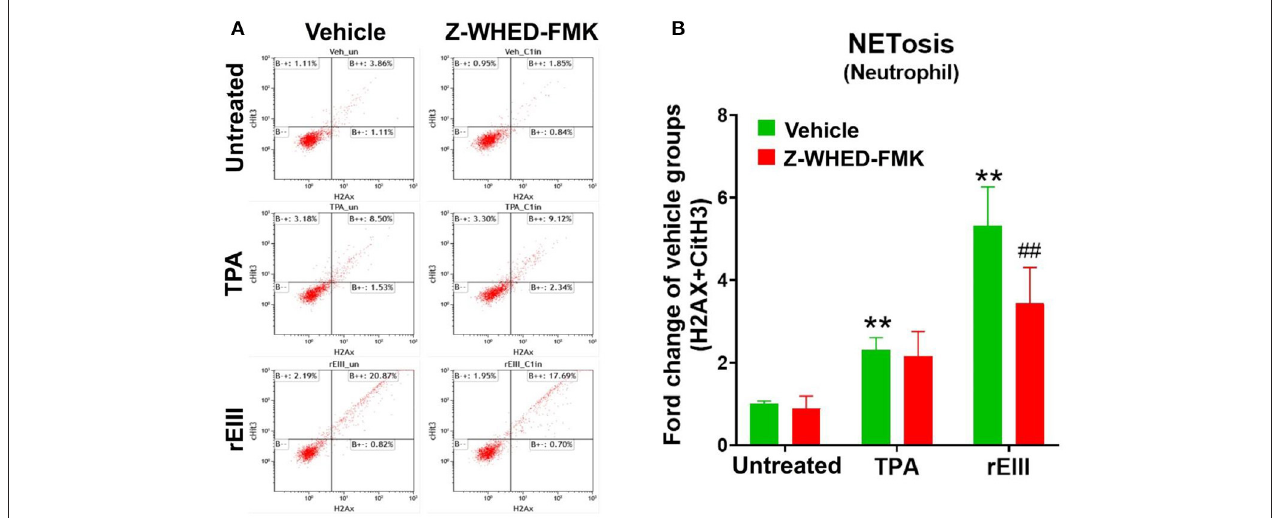
FIGURE 1 | Essential role of caspase 1 in DENV rEIII-induced NETosis. The gating of flow cytometry analysis of vehicle, 12-O-tetradecanoylphorbol-13-acetate (TPA, a positive control NETosis inducer; 2nM) and DENV rEIII (0.6 µ M) challenged (1h) wild mice neutrophils (1 × 10 5 ) with or without caspase 1 inhibitor Z-WHED-FMK pretreatments (30min) (A) . The quantified results of flow cytometry analysis, which reveal that TPA and rEIII treatments markedly induced NETosis formation; by contrast, caspase 1 inhibitor Z-WHED-FMK treatments can only considerably suppress rEIII-induced NETosis, but not TPA-induced NETosis (B) . n = 6, ** P < 0.01, vs. untreated controls; ## P < 0.01 vs. vehicle